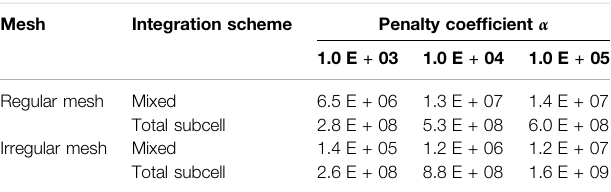
Table 2 ; Figure 7 present comparisons of the stiffness matrix condition numbers obtained using smeared and subcell integration with different penalty coef fi cients and partition ratios. The penalty coef fi cient α (cid:2) 0 indicates that no penalty constraint has been imposed. It is observed that as R approached 0, the condition number increased in all cases in a nearly linear manner; however, the condition number corresponding to smeared integration was much smaller than that corresponding to subcell integration, and the increasing slope was much smaller. For subcell integration, the condition number showed almost no change after an interface